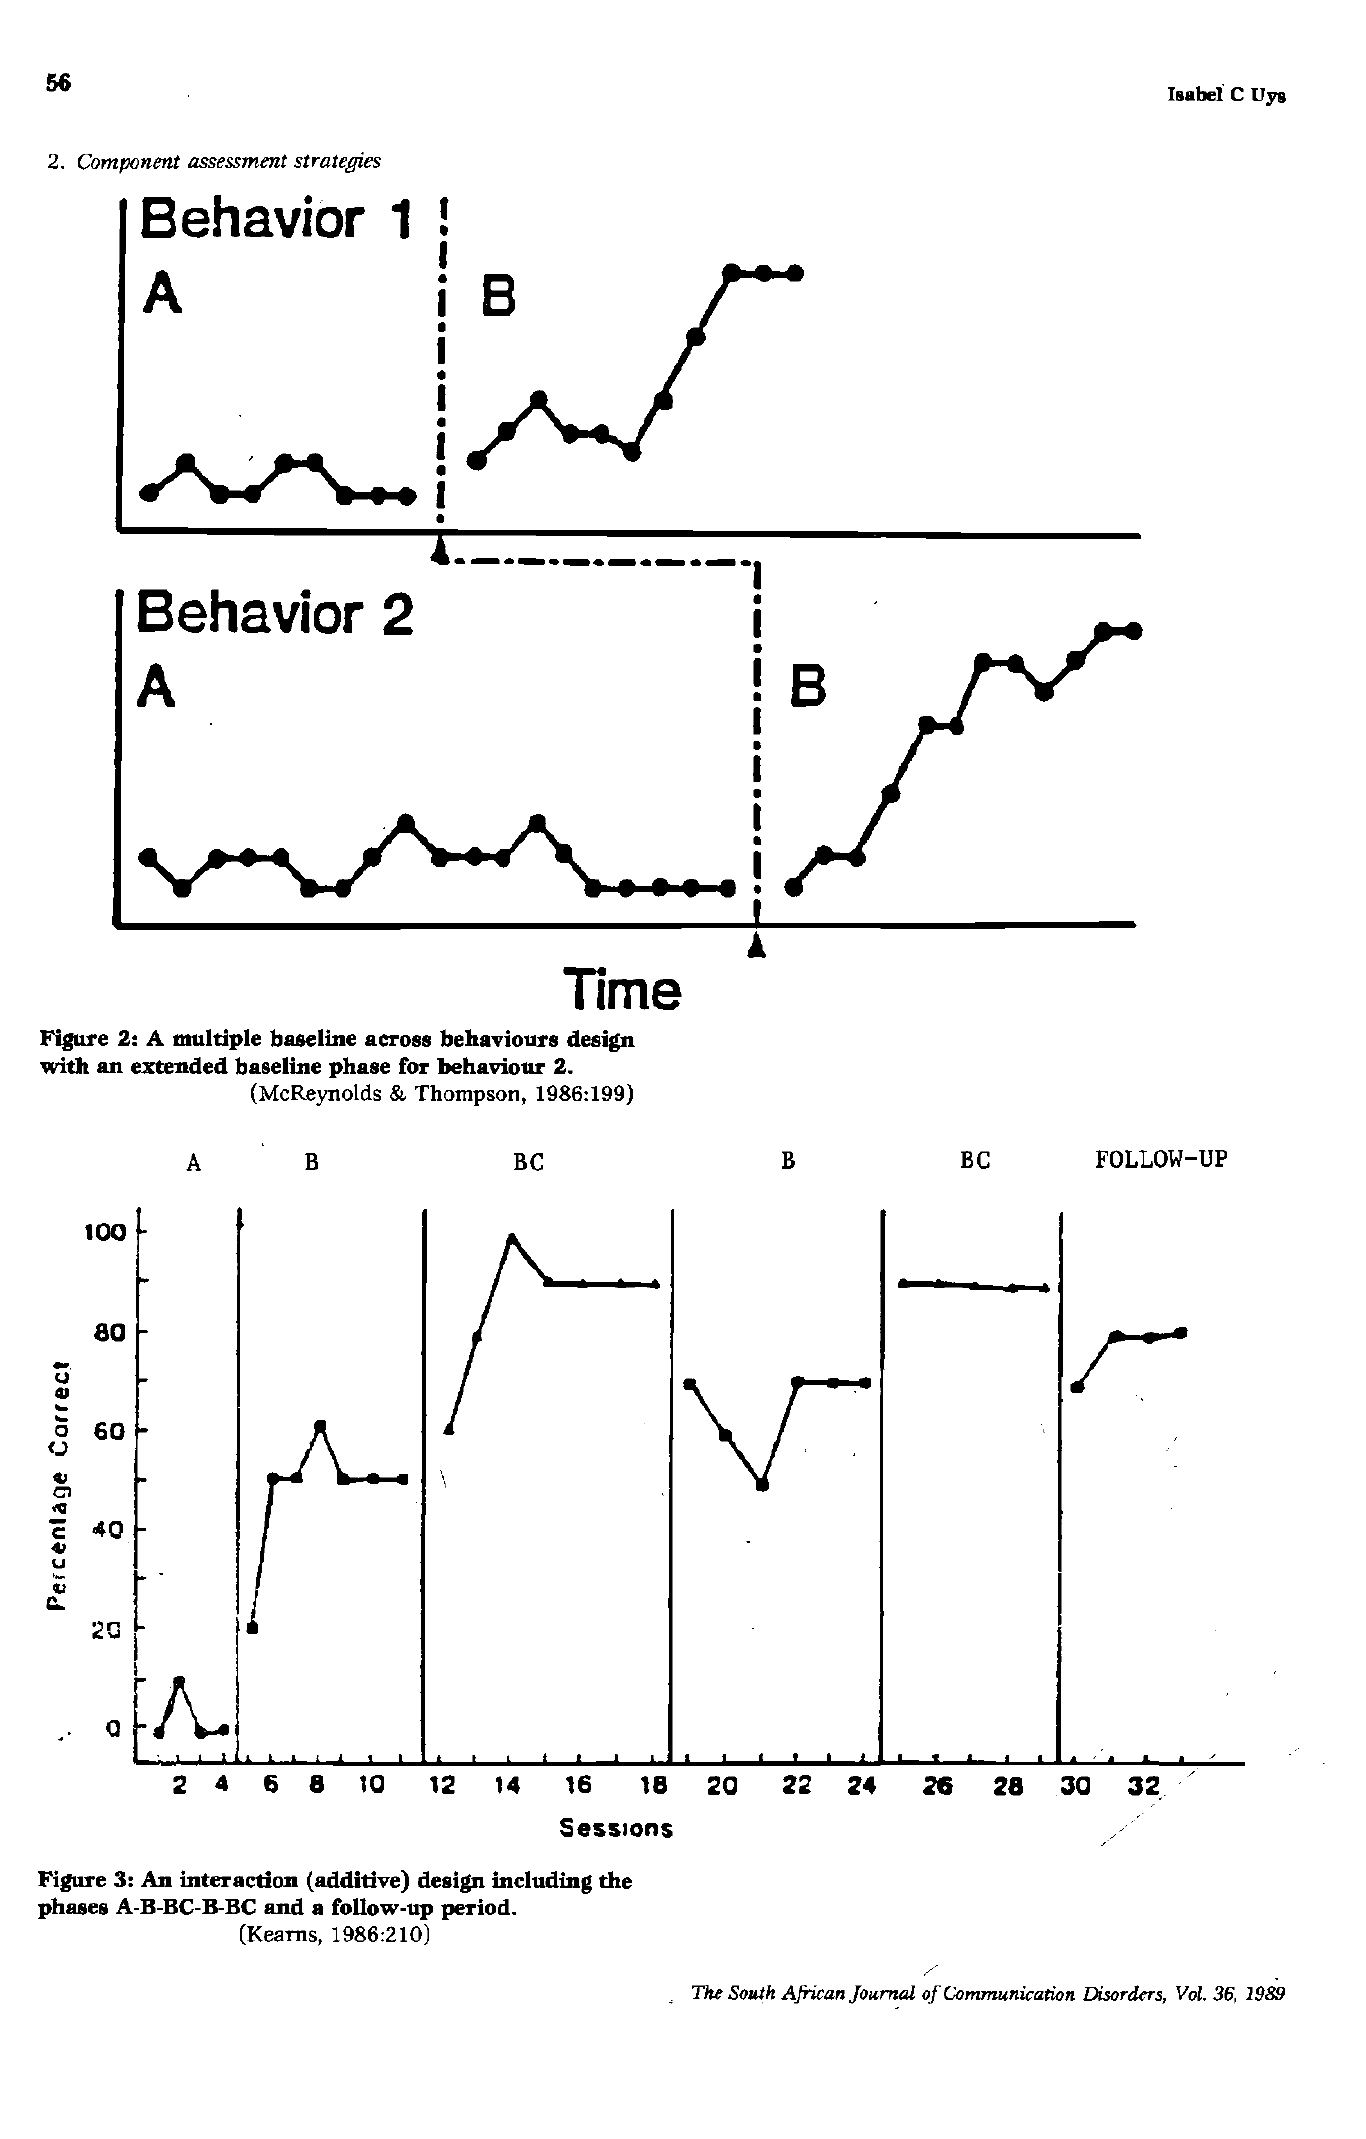
Figure 3: An interaction (additive) design including the phases A-B-BC-B-BC and a follow-up